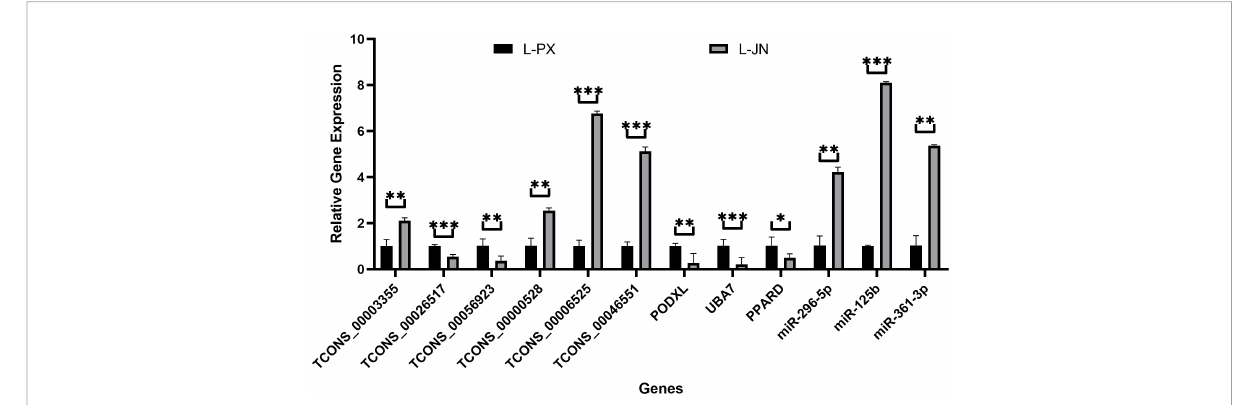
FIGURE 6 qRT-PCR validation results. The differential expression of genes between intramuscular and subcutaneous adipose tissue in Laiwu pig was veri fi ed qRT-PCR. *p < 0.05; **p < 0.01; ***p <